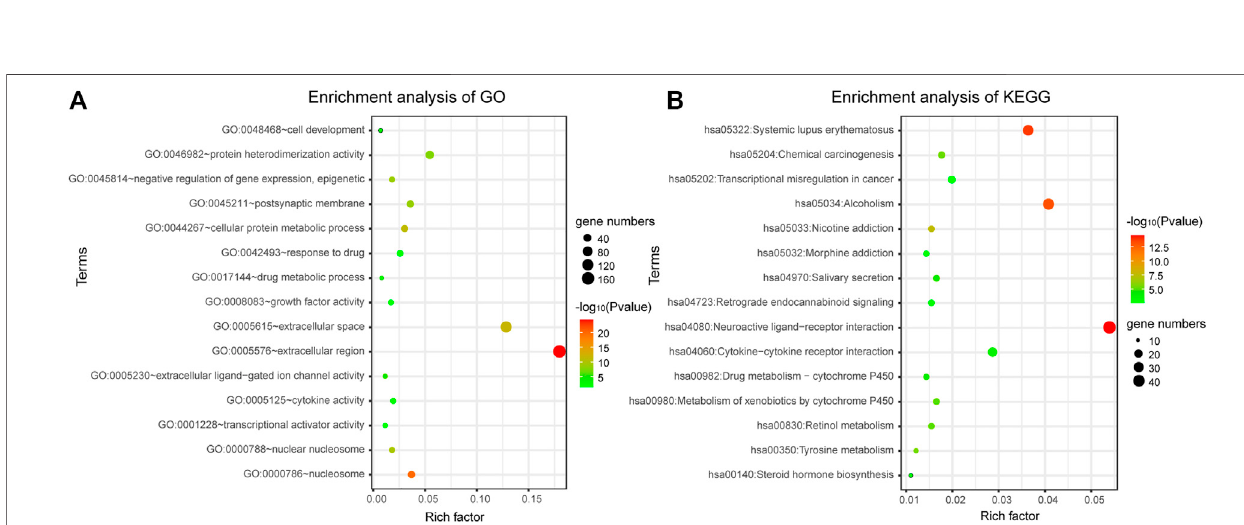
where the red bar represents breast cancer patients and the blue bar represents normal control samples. As can be seen from this fi gure, there are indeed signi fi cant differences in these genes